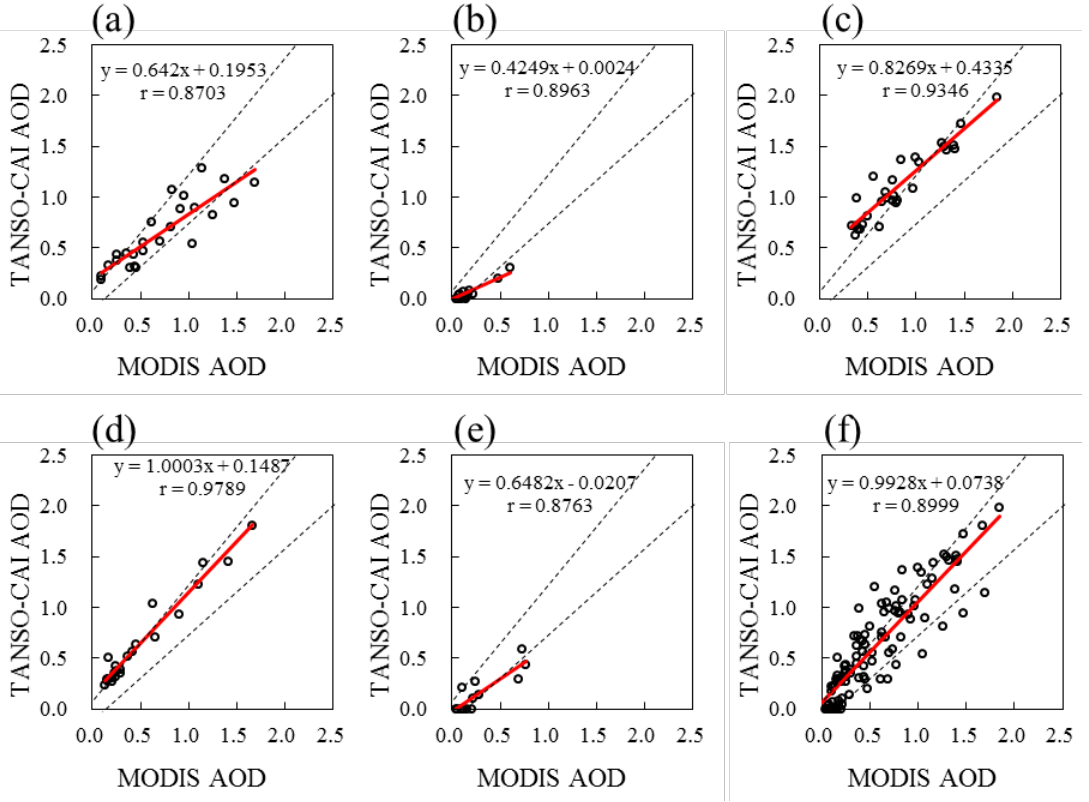
Figure 12. Comparison of TAOSN-CAI retrievals against MYD04_3K AOD over different regions. ( a ) Vientiane site; ( b ) Xinglong site; ( c ) Dhaka_University site; ( d ) Chiang_Mai_Met_Sta site; ( e ) Ussuriysk site; and ( f ) for all sites. The red solid and dashed lines are the regression line and the expected error (±(0.1 + 15% AOD AERONET )) envelope line, respectively.